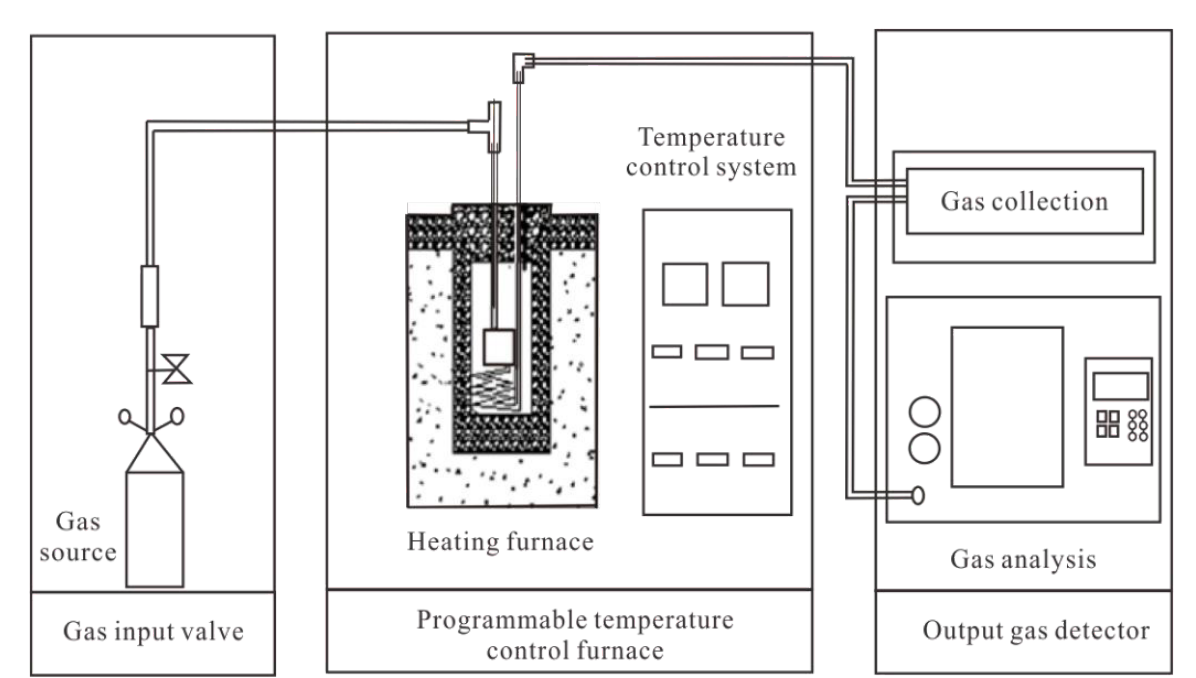
Table 2. Raw material ratios of reference samples.